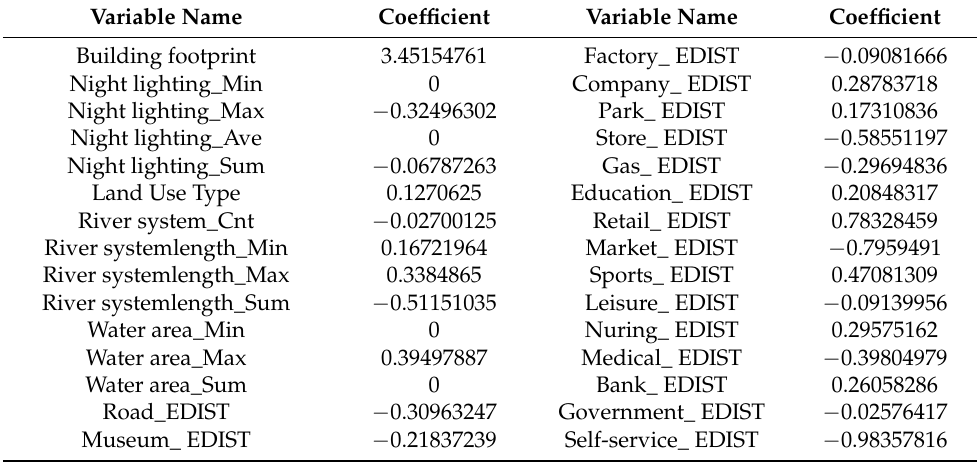
Table 5. Coefficients of